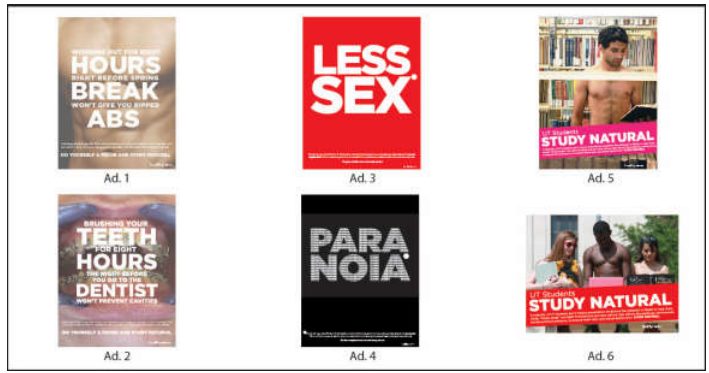
Figure 1. Health campaign interventions designed based on the Health Belief Model (Ad No. 1 to Ad No. 4) and the Theory of Planned Behavior (Ad. No. 5 and Ad. No. 6) frameworks. Ad: Advertisement.